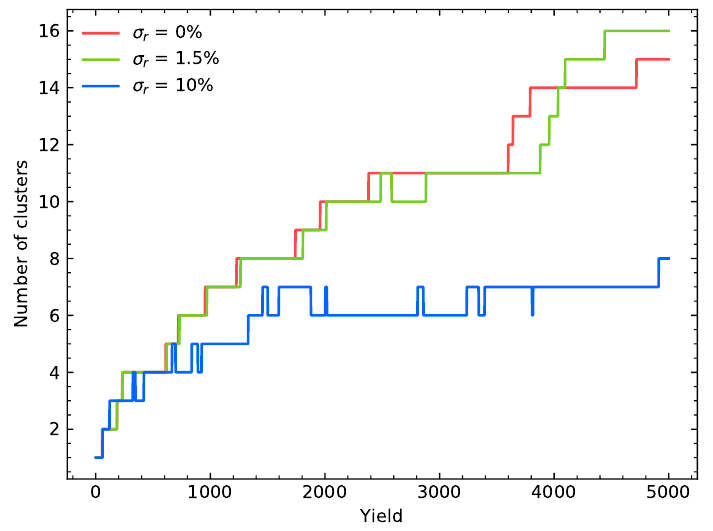
Figure 5 . The number of clusters as a function of the signal yield for the observable dBR( B ! D 0 (cid:28)(cid:23) ) = d q 2 for three di(cid:11)erent relative systematic uncertainties (cid:27) r